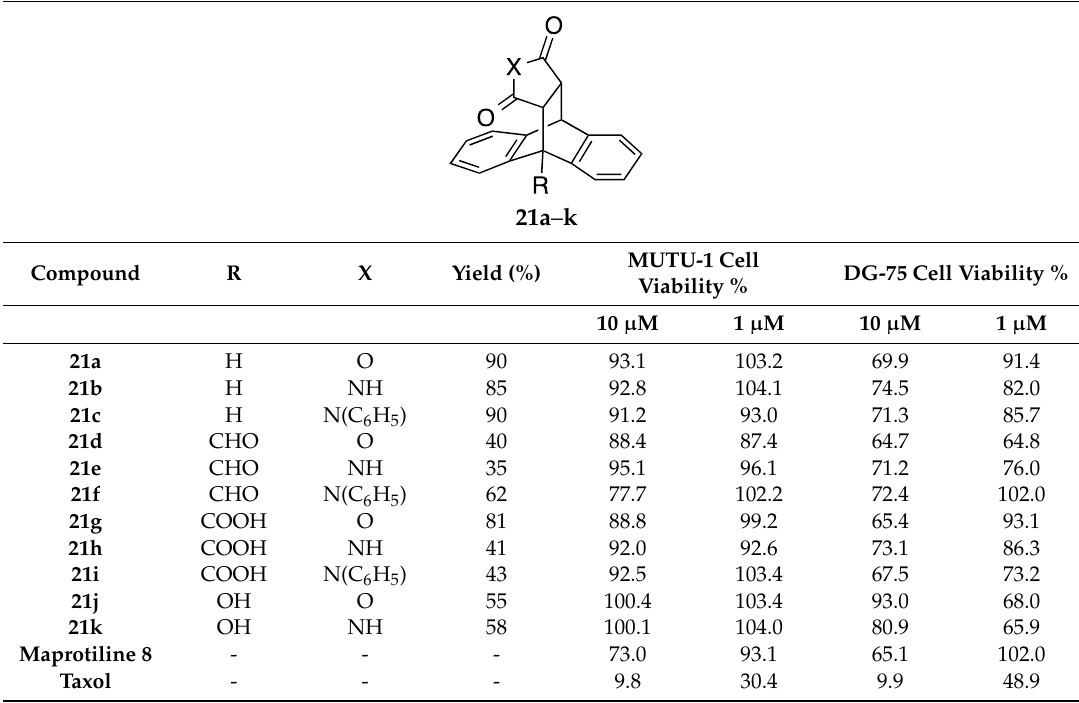
Table 8. Yields and preliminary cell viability data for compounds 21a – k (Series VI) in MUTU-1 and DG-75 Burkitt lymphoma cell lines a .